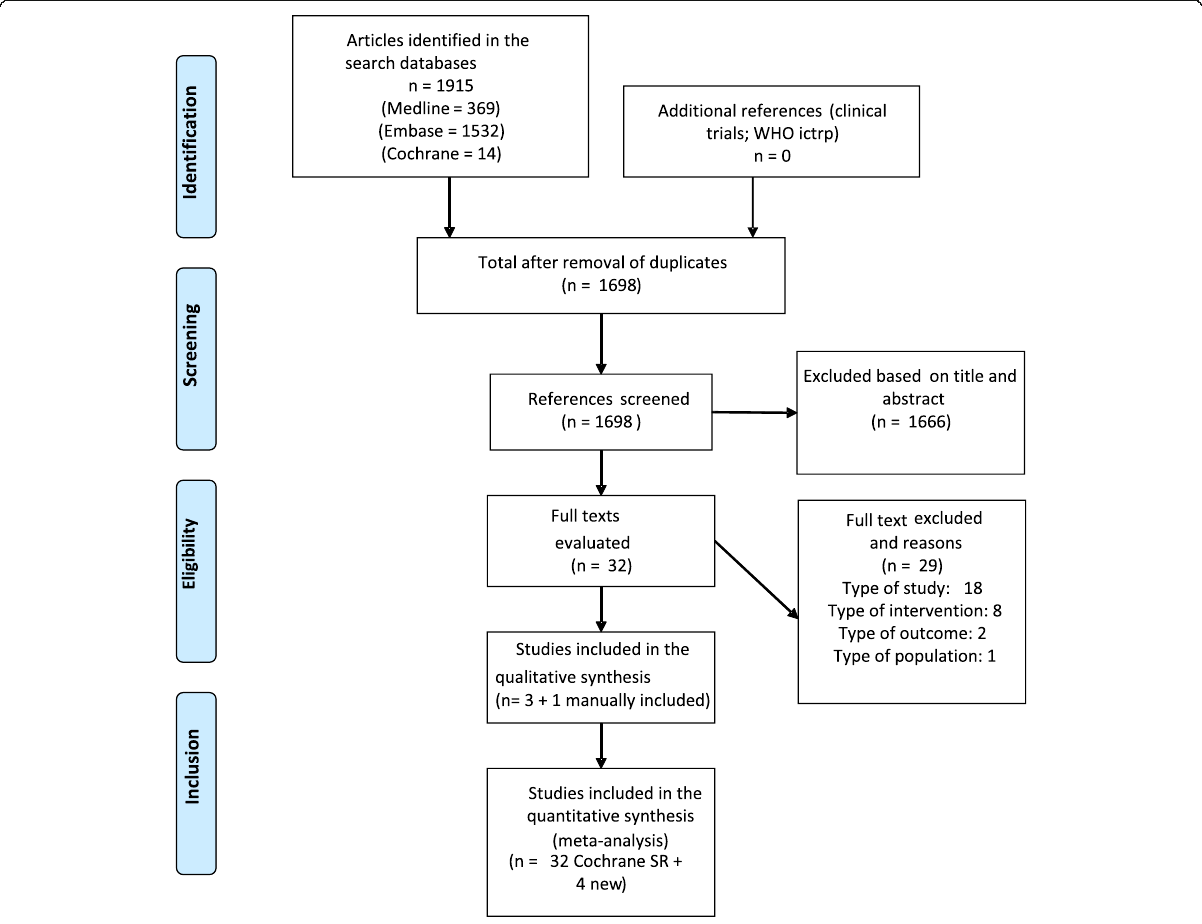
Fig. 1 PRISMA flowchart of selection and eligibility of the studies included in the systematic review